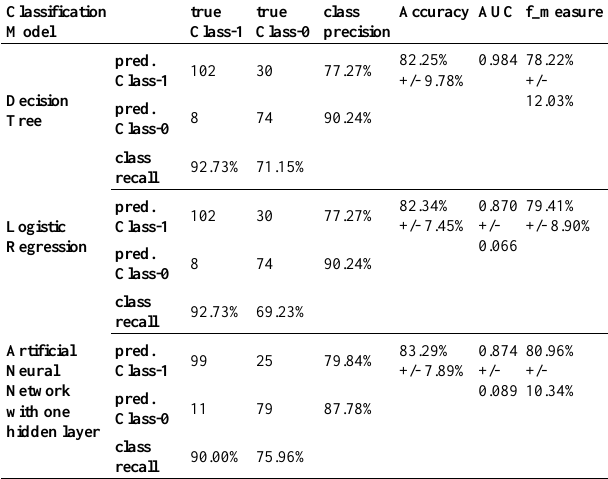
Table 3. Results based on the selected performance measures. Classification